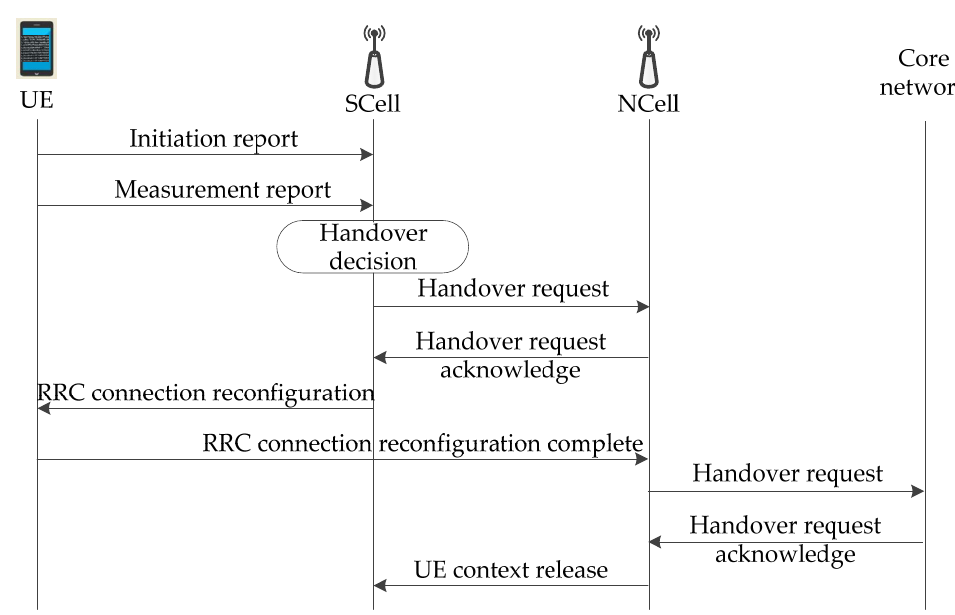
Figure 10. Signaling process of the fast handover algorithm.